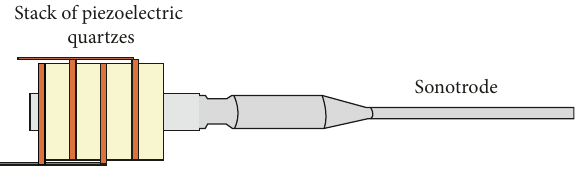
Figure 3: The stack of piezoelectric quartzes transforms the electrical energy of the generator into a longitudinal, mechanical vibration of the sonotrode tip.